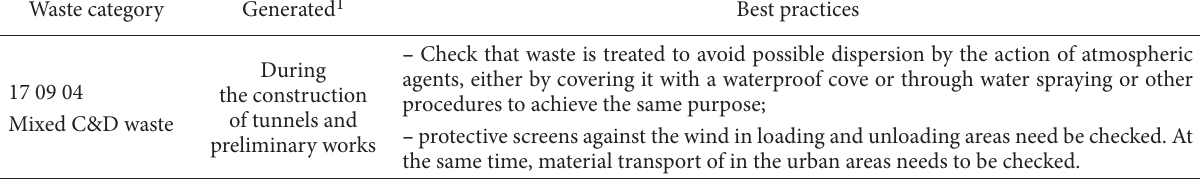
Table 3. List of best practices applied to the waste categories generated in railway works Waste